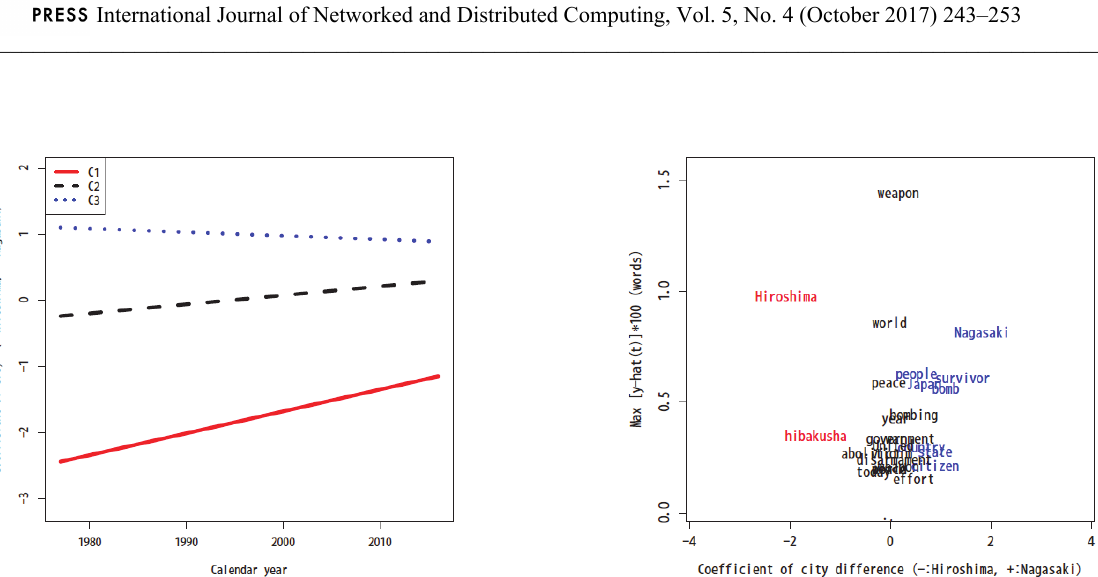
Fig. 10. Scatter plot of keyword's frequency by cluster in 1997